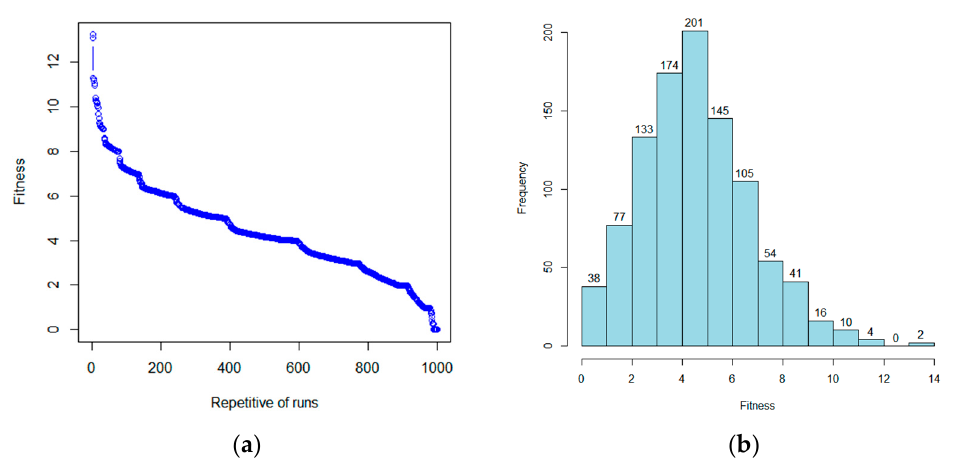
Figure 3. Worst ‐ case analysis with the Rastrigin (30) function. ( a ) The worst fitness obtained by the CFA program as the number of repetitive runs increases. ( b ) The number of program runs with which each performance level is reached.